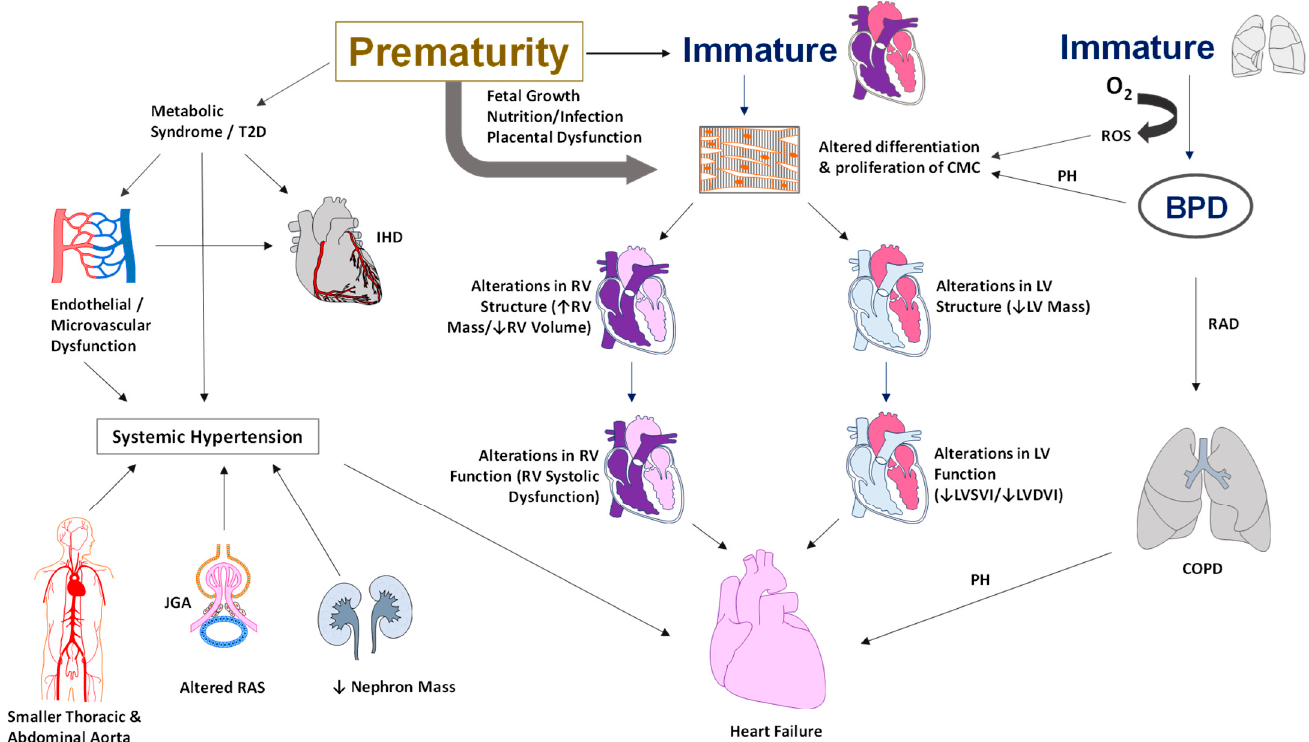
Figure 1. Illustration of the pathophysiology of cardiovascular morbidities in adults born preterm. Alterations in the cardiac structure include a smaller RV or LV systolic or diastolic volume and an increase in RV or LV mass. Functional changes include systolic and diastolic dysfunction, hypercontractile heart, and low cardiac output. Metabolic syndrome and a higher risk of type II diabetes contribute to endothelial dysfunction leading to systemic hypertension and ischemic heart disease. In addition, the smaller diameter of the thoracic and abdominal aorta, lower nephron mass, and alterations in sodium balance with activation of the renin-angiotensin system all contribute to the development of systemic hypertension in adults born preterm. Abbreviations: BPD—bronchopulmonary